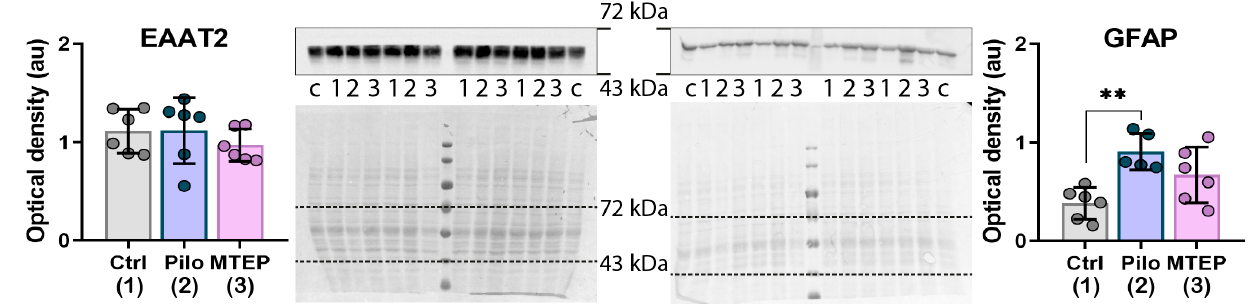
Figure 4. Western blotting data of proteins production in the dorsal hippocampus in the chronic phase. For inserts, the upper part shows the chemiluminescent signal, the lower part shows the Ponceau S. For bands, c is calibrator sample, 1 is Ctrl, 2 is Pilo, and 3 is MTEP group samples. Each dot represents one animal; the columns indicate average values and error bars show standard deviations. One-way ANOVA was used to determine the effect of MTEP therapy (excitatory amino acid transporter 2 (EAAT2): F 2, 17 = 0,66, p = 0.53; glial fibrillary acidic protein (GFAP): F 2,16 = 8.1, p < 0.01). Asterisks indicate significant differences between groups according to Tukey’s post hoc tests: ** p < 0.01.